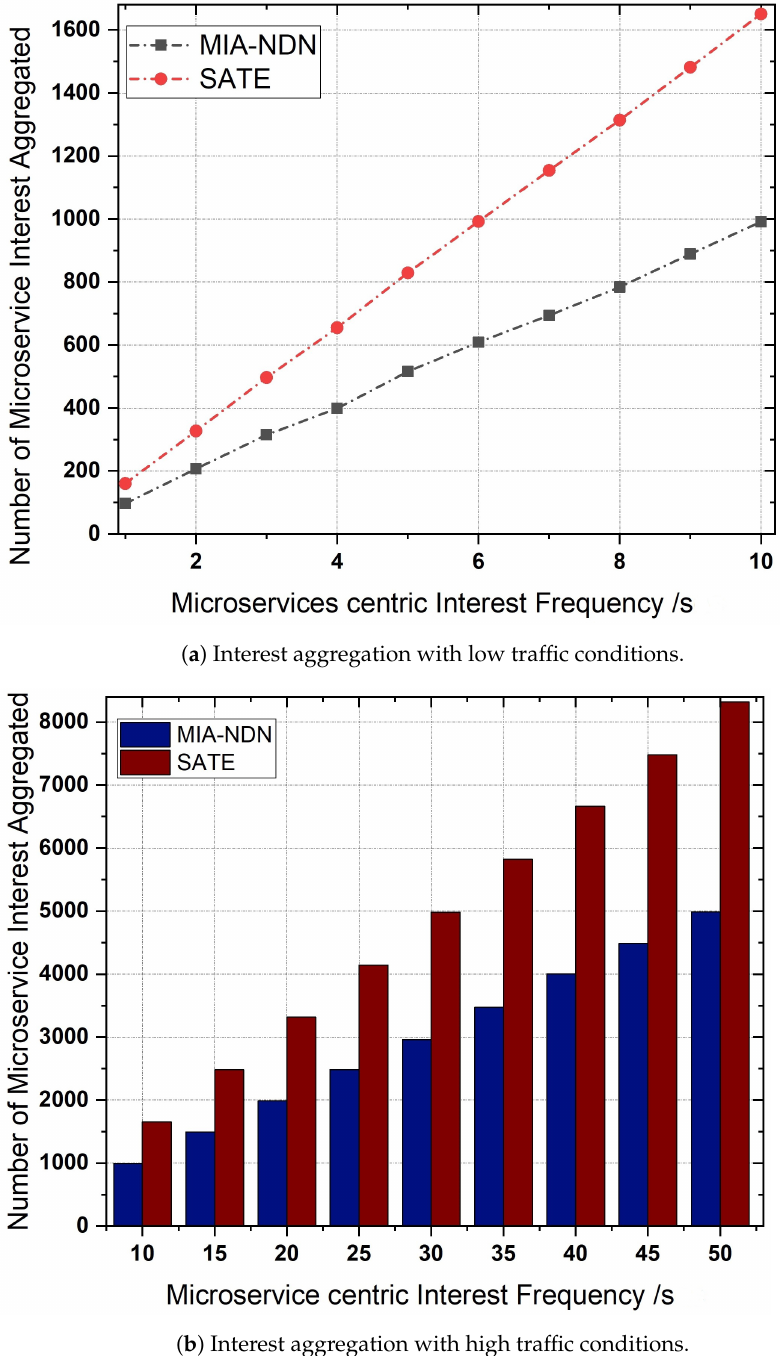
Figure 7. Microservice interest aggregation as a function of microservice interest